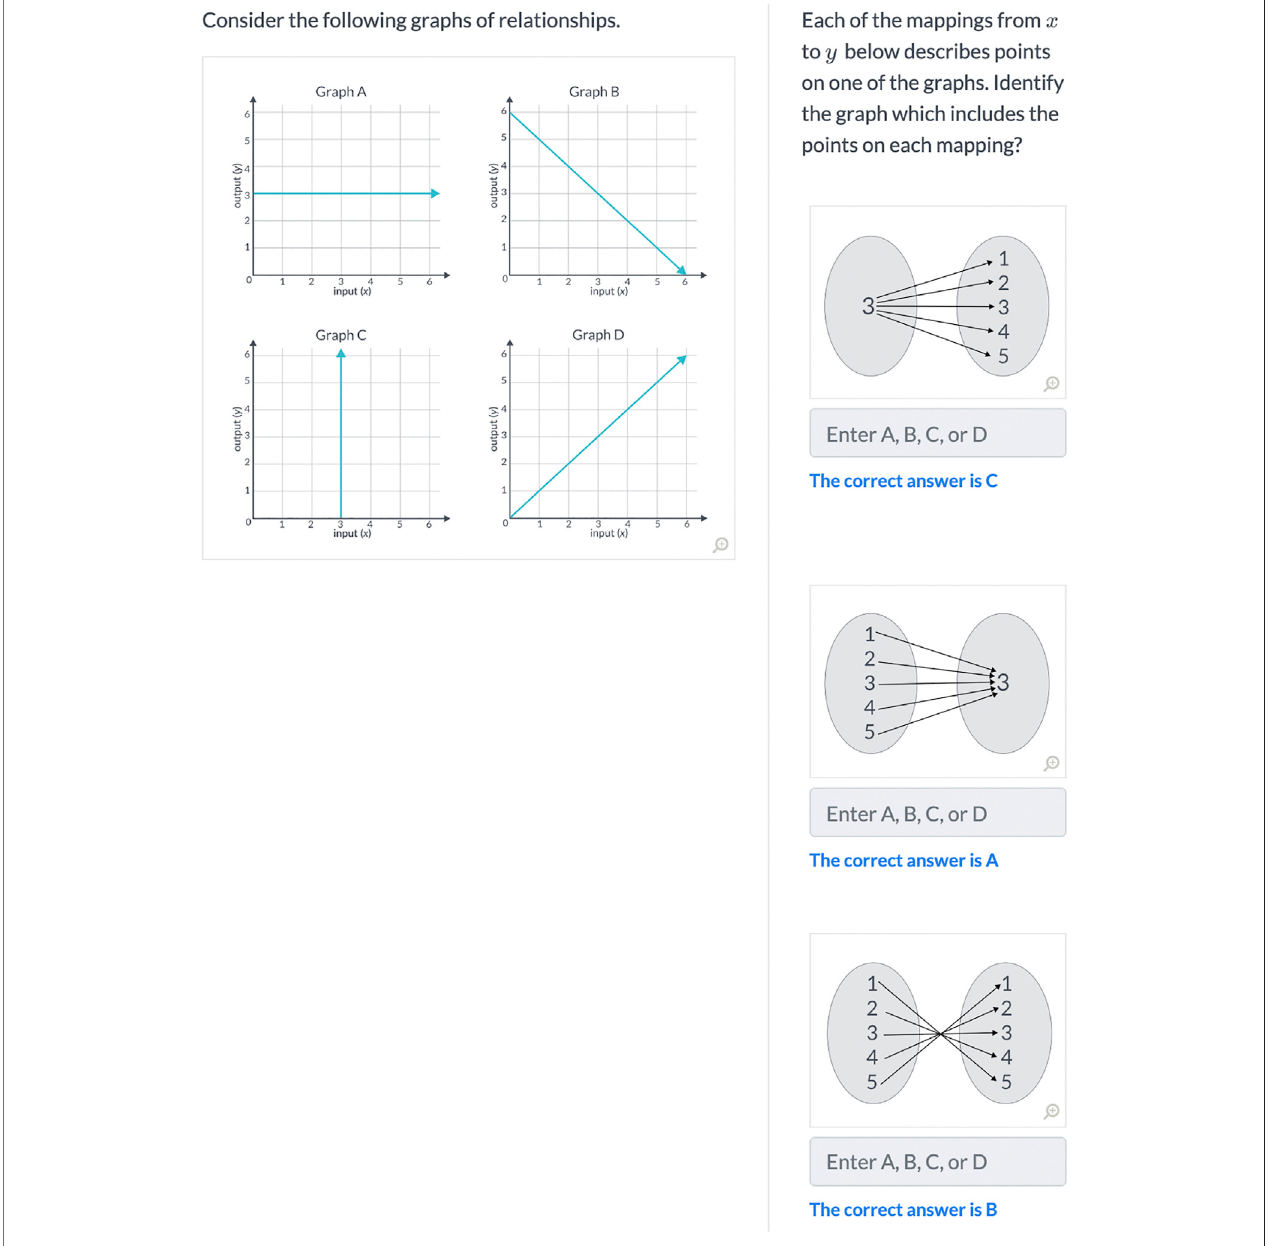
FIGURE4| Item 1267alignedto L3: “ Givengraphsor verbal descriptions oftwo-variable relations,classi fi esthem asonetoone, many-to-1, 1-to-many, or many- to-many ” ; dif fi culty parameter b (cid:1) 0.71 (predicted: − 0.39).